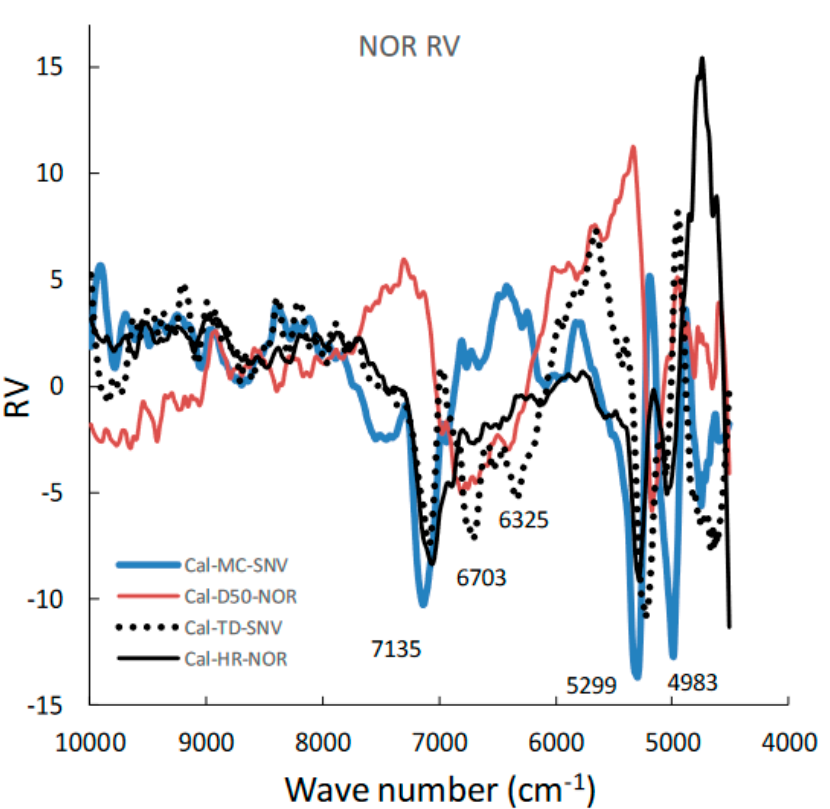
Figure 5. Area-normalized RVs of the best calibration models for predicting the MC, D50, TD, and HR during the HSWG process using NIRS/PLSR.